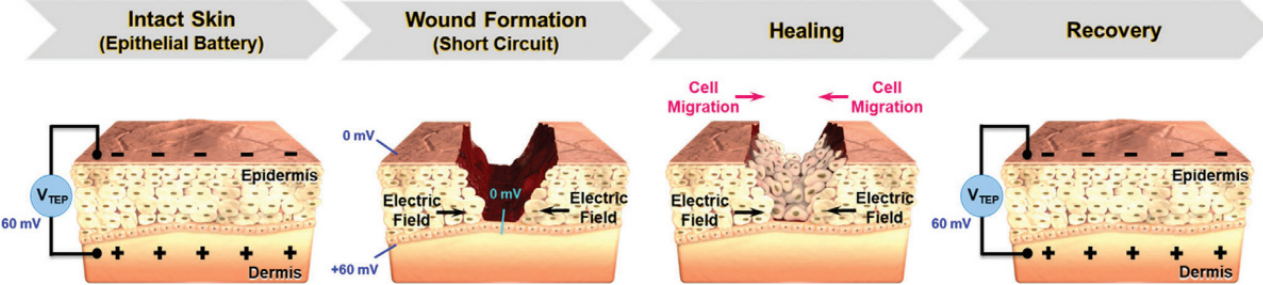
Figure 9. TEP and electric field at wound site before and after healing process. Reproduced with permission from [154]. Copyright (2021) John Wiley and Sons.